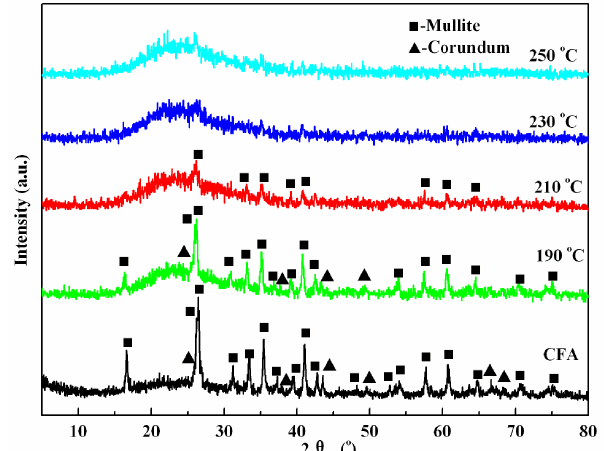
Figure 7. XRD spectra of CFA and residue changing with calcination temperatures.